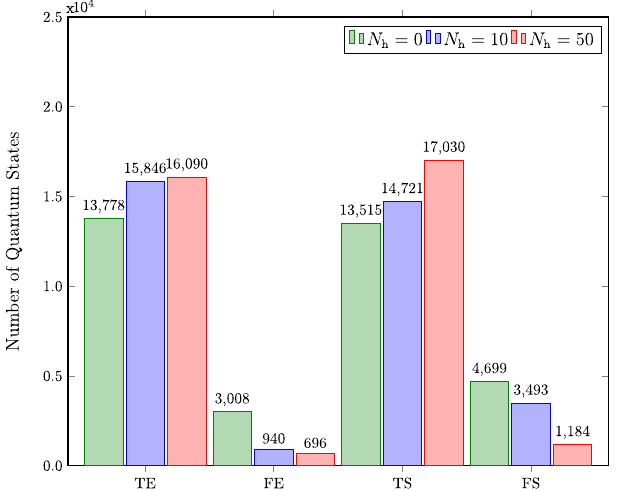
Figure 2. Bipartite quantum states classified as truly entangled (TE), falsely entangled (FE), truly separable (TS), and falsely separable (FS) by testing classifiers with N h = 0 , N h = 10 , and N h = 50 , where N h denotes the number of neurons in the hidden